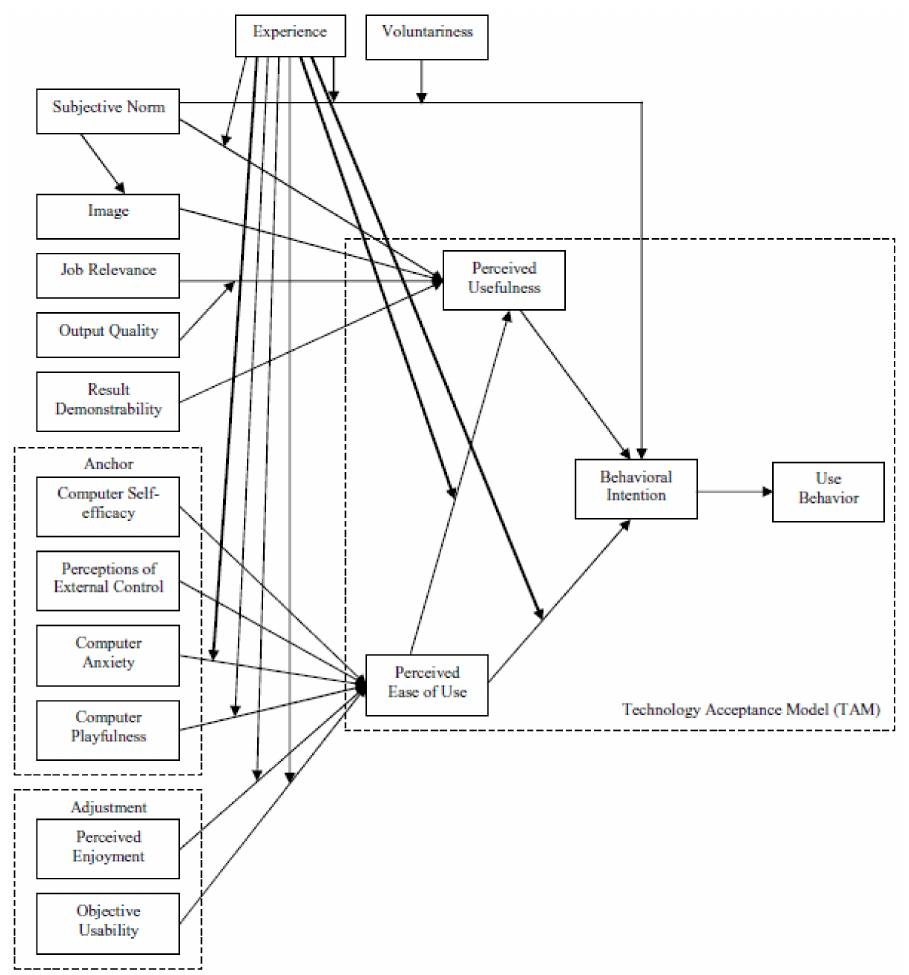
Figure 2. The TAM-3 (The Technology Acceptance Model 3) model. Retrieved from Venkatesh V,